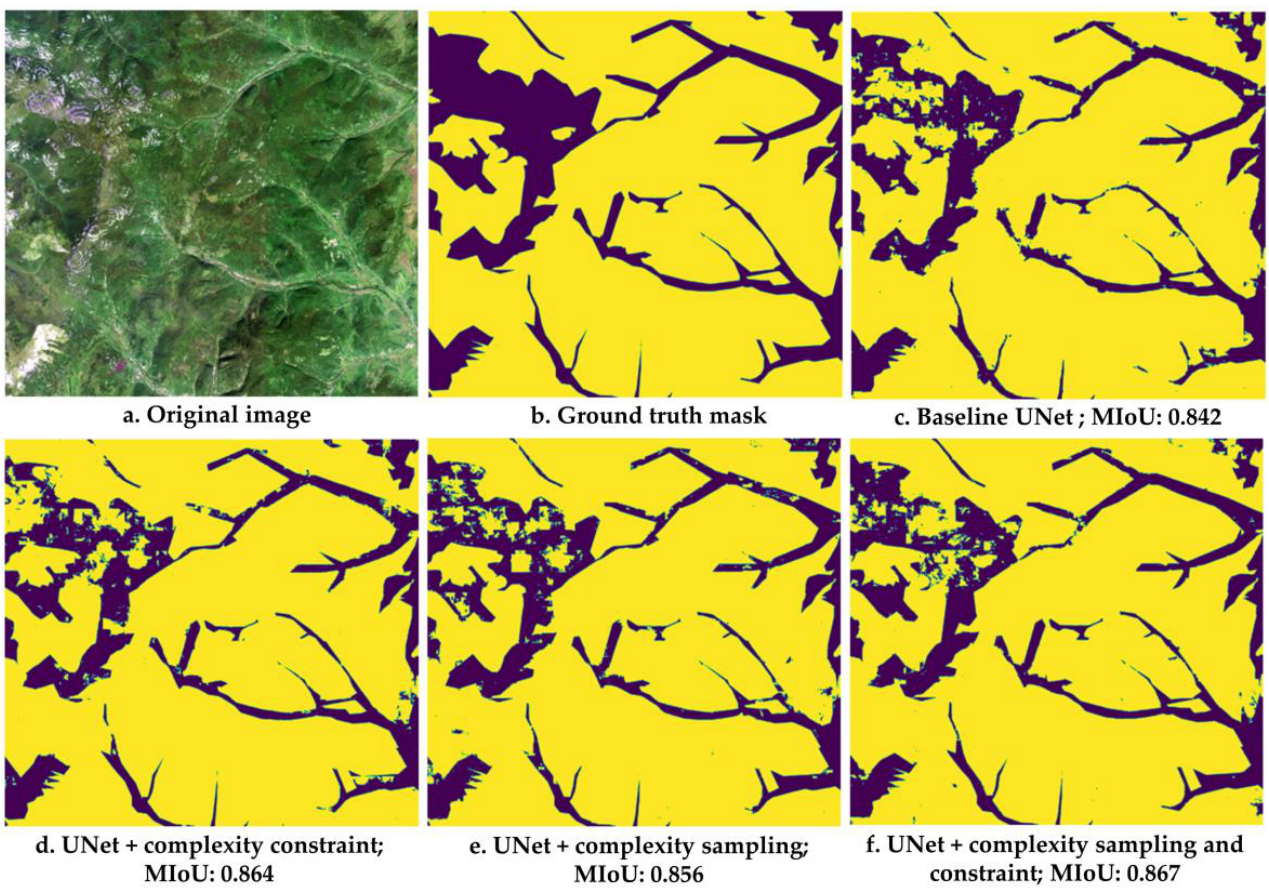
Figure 12. Comparison between meadow segmentation results of baseline UNet, UNets with complexity-informed constraint/sampling, and UNet with both. ( a ) shows the RGB images depicting true colors; ( b–f ) display yellow masks representing the meadow feature for ground truth ( b ) or predictions ( c – f ). Table 4. Comparison of the performance of different deep learning